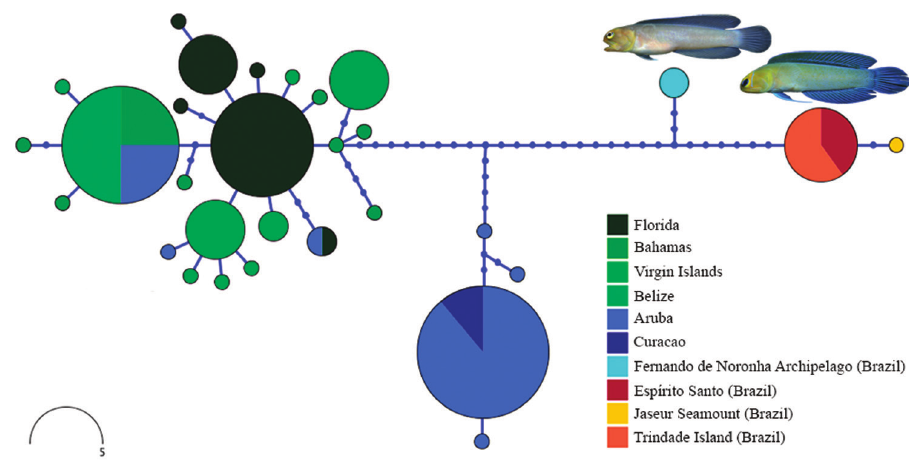
Figure 25. Haplotype network of the Opistognathus aurifrons complex. Dark solid circles represent un- sampled intermediate haplotypes, lines connecting haplotypes represent single